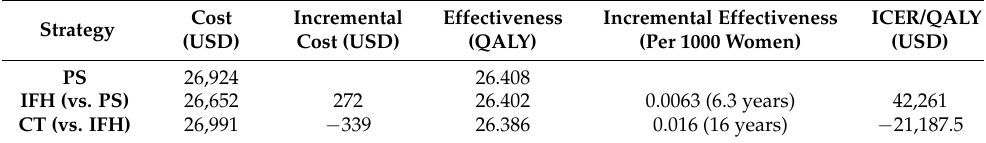
Table 4. Cost-effectiveness analysis of BRCA testing